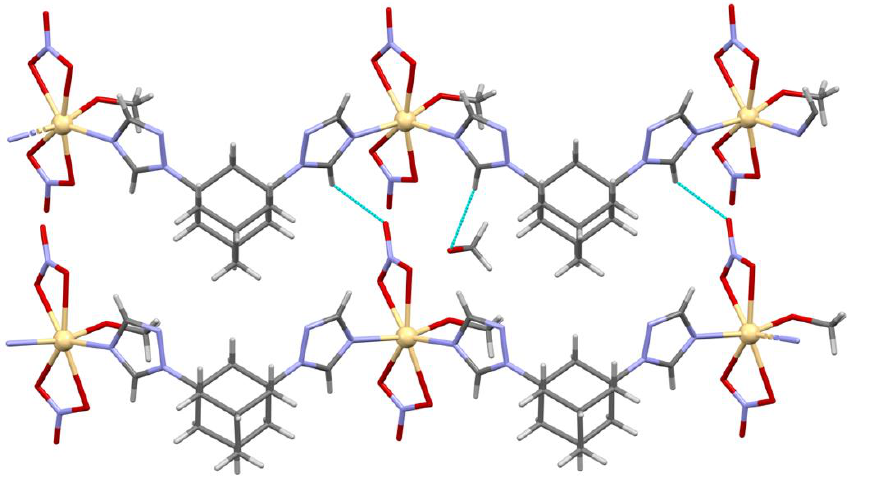
Figure 6. Chains of coordination polymer 3 with short CH···O contacts. The view is along the c axis. Only one solvate CH 3 OH molecule is shown for clarity. Atom legend: Cd—yellow balls; C—dark gray dots; N—blue dots; O—red dots; H—white dots.